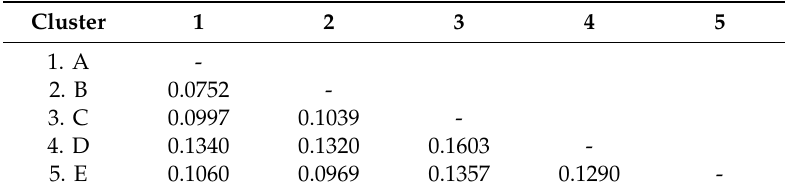
Table 3. Pairwise F ST based on the STRUCTURE clusters of Emys trinacris